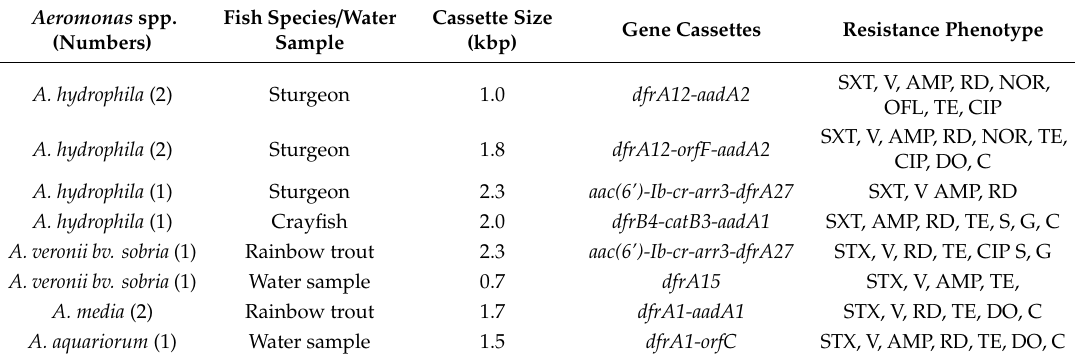
Table 3. The size and contents of gene cassettes and antibiotic resistance profile of sequenced MDR Aeromonas spp.